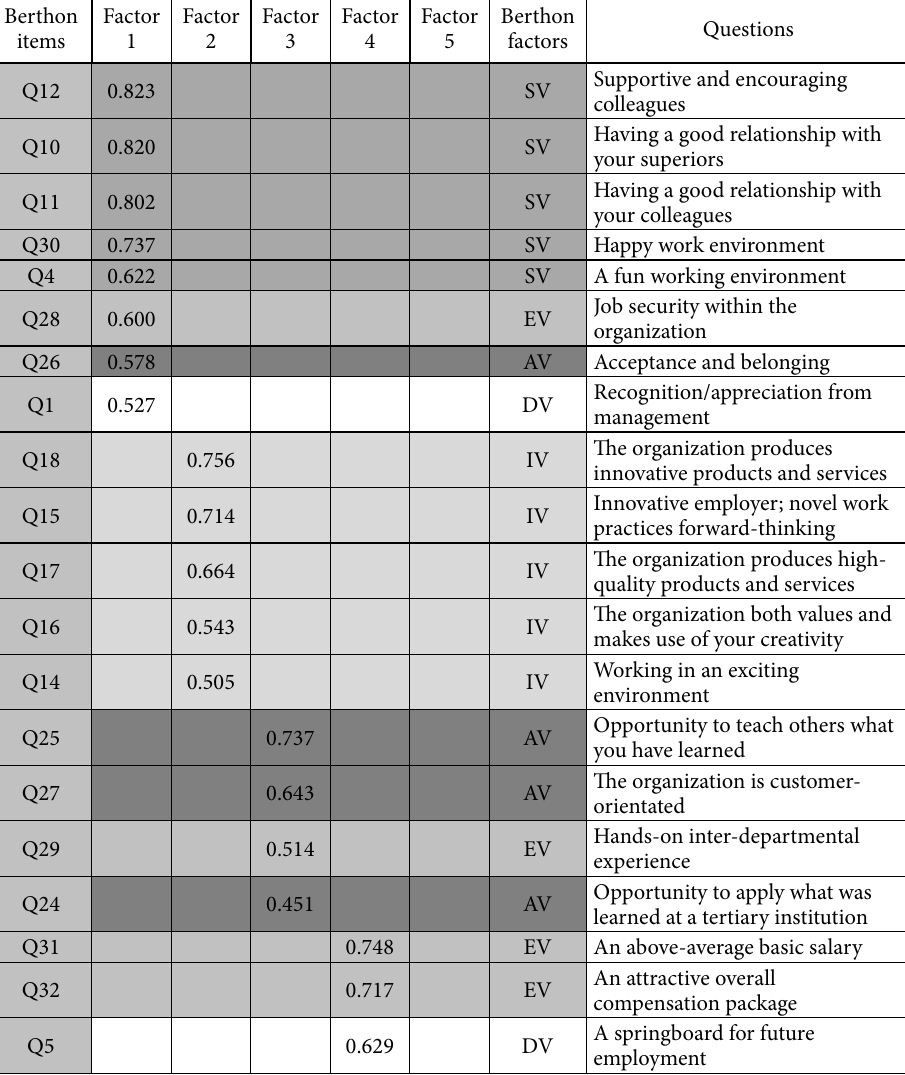
Table 3. Factor analysis of items (source: own, 2018) Berthon